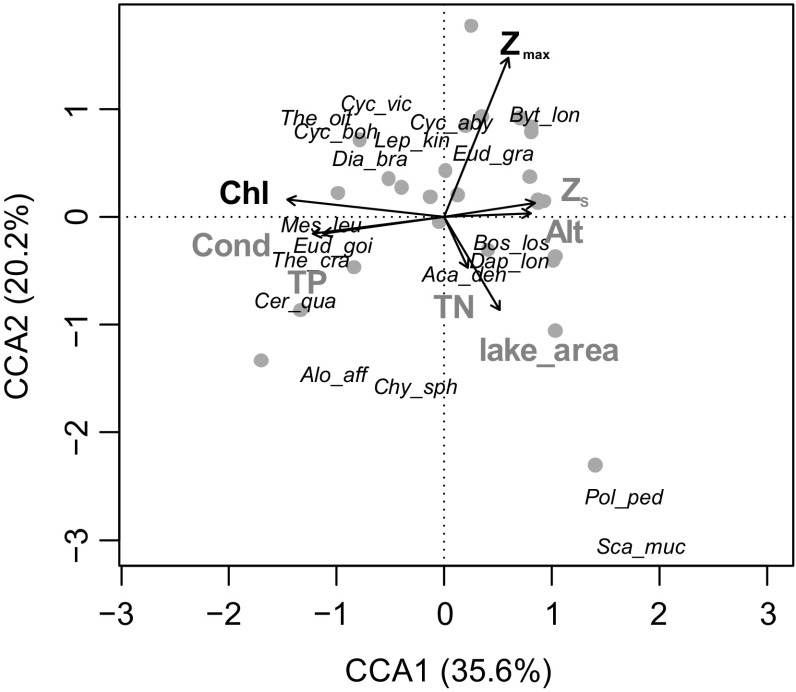
 CCA ordination plot of Austrian and German lakes (significant environmental predictors in black; abbreviations of predictors in Table 1). Species abbreviations are based on the first 3 letters of genus and species names (see Supplemental Table S4), apart from Eudiaptomus gracilis and E. graciloides, which are differentiated as Eud_gra and Eud_goi).